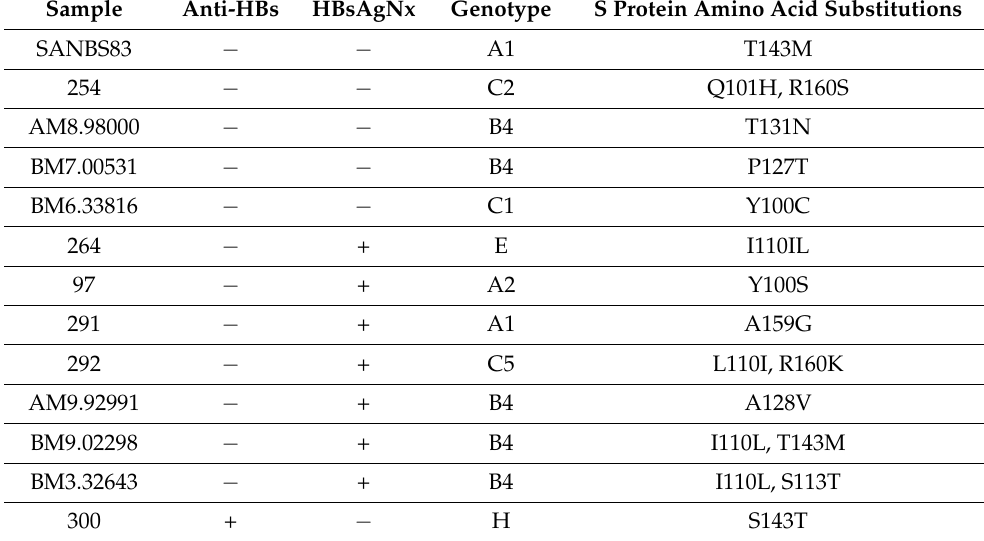
Table 2. Data for NAT yield samples with substitutions in amino acids 100-160 of the HBsAg S